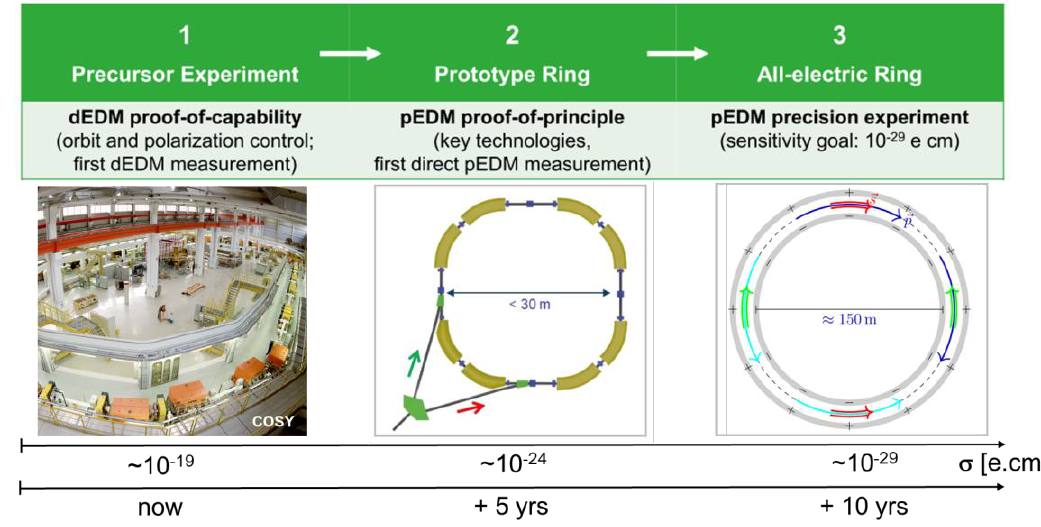
Figure 8. Stages of the strategy for charged particle EDM searches as outlined by the CPEDM collaboration. The EDM sensitivity goals are given for each step. Stage 1 is currently ongoing, while the timeline for stages 2 and 3 is of the order of 5 and 10 years, respectively.